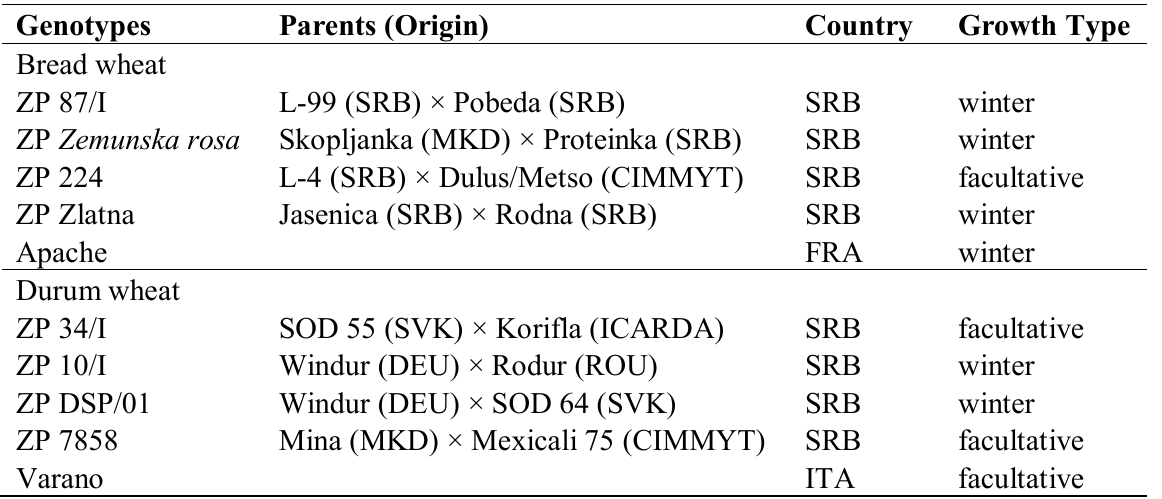
Table 1. Name, pedigree, growth type and origin of bread and durum genotypes; country code from the UN